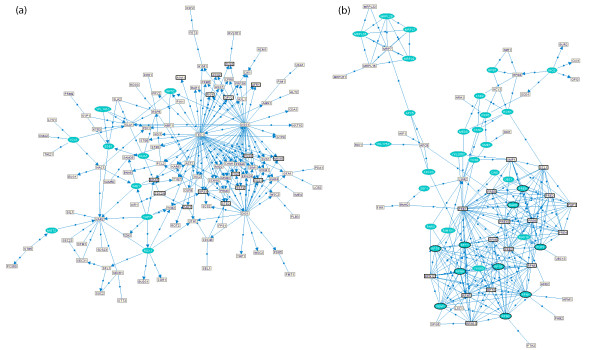
Two of the JACSs identified in the S. cerevisiae analysis. (a) The pheromone response subnetwork, (b) The proteolysis subnetwork. The front nodes are the yellow (light gray) rectangles and the back nodes and the blue (dark gray) ovals. The genes annotated with pheromone response (a) and proteolysis (b) are drawn with thicker border. Gene lists, expression matrices and interactive display of all the subnetworks are available at the supplementary website.